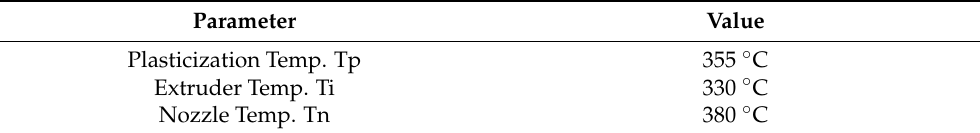
Table 3. Printing temperatures.